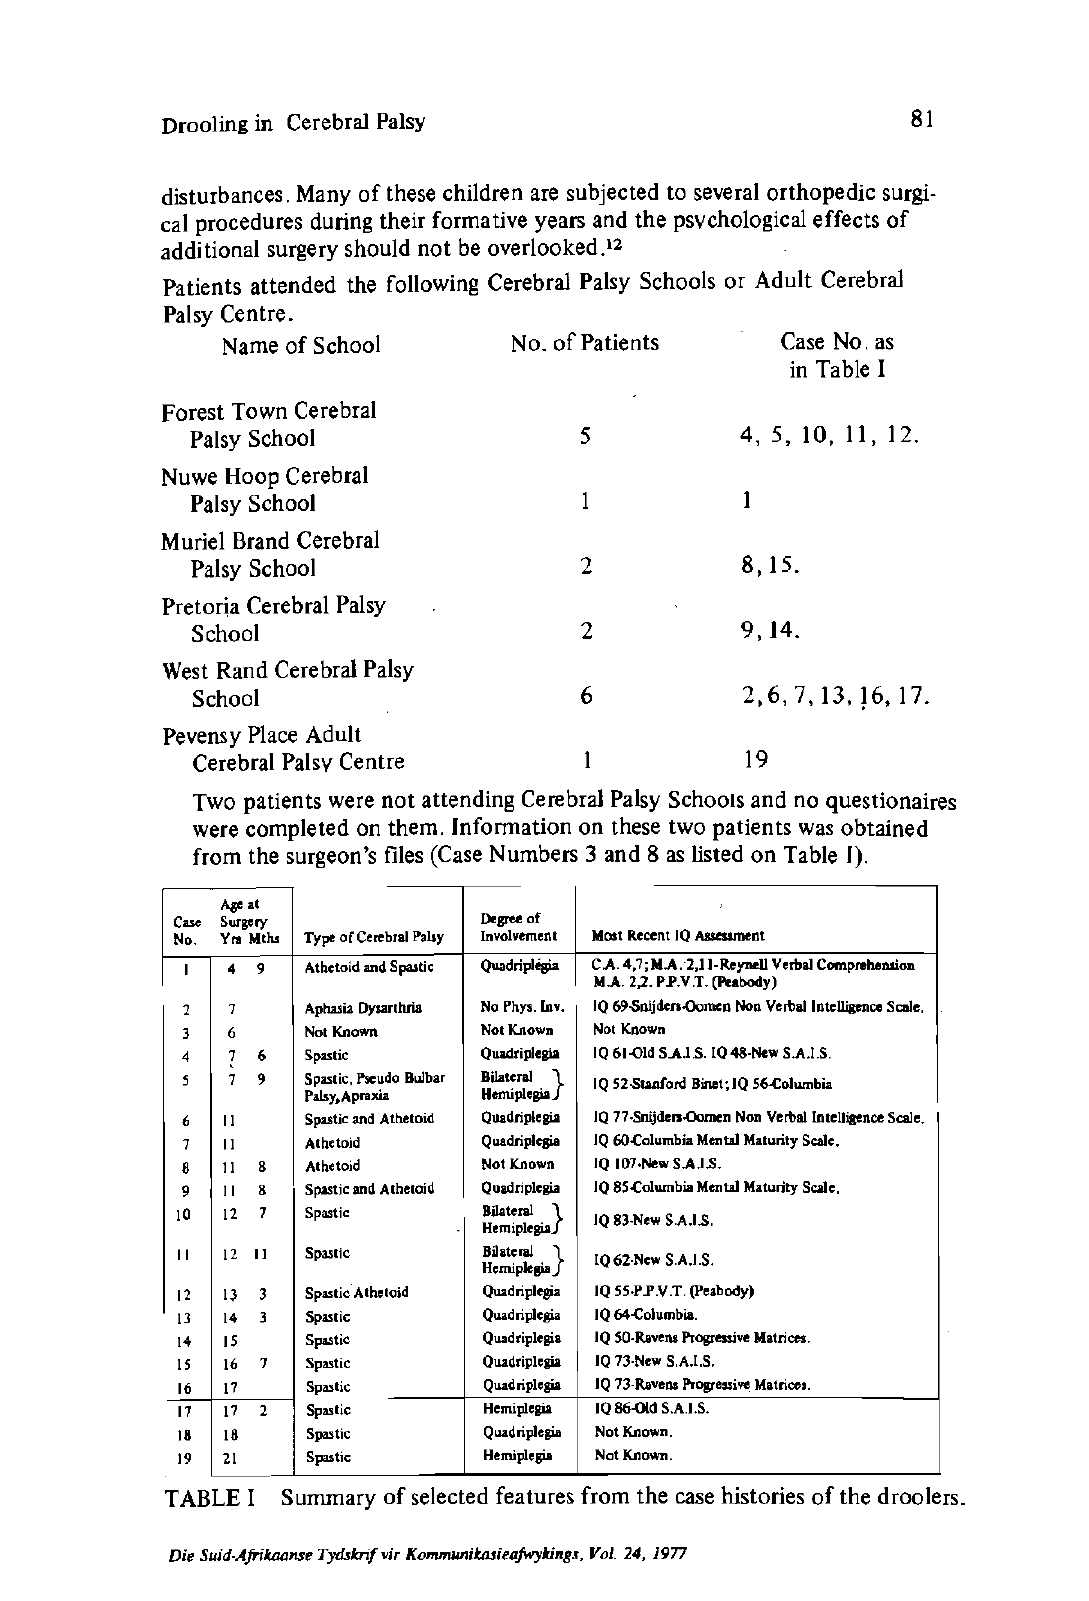
Summary of selected features from the case histories of the